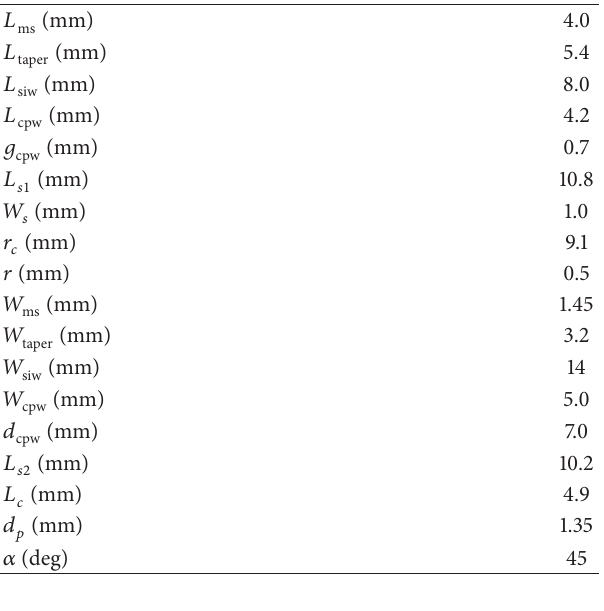
Table 1: Geometrical parameters of the proposed antenna.